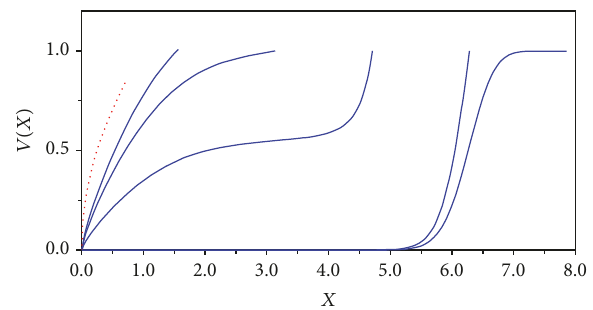
Figure 2: Nonlocal Lyapunov functions (solid blue) for system (41) computed on [10 −4 , 𝜋𝑘/2] with 𝑘 = 1, 2,3, 4, 5 . Since the value 𝑉(𝑥) is the probability that the solution started at 𝑥 leaves the domain of the Lyapunov function 𝑉 at the outer boundary, one obviously gets unnecessary conservative estimates on the 𝛾 -BOA if the domain is too small. Extending the domain beyond ca. 7.5 however does not lead to notably larger estimates. The local Lyapunov function 𝑊(𝑥) = |𝑥| 1/2 (dotted red) is plotted on the interval [0, 2 −1/2 ]